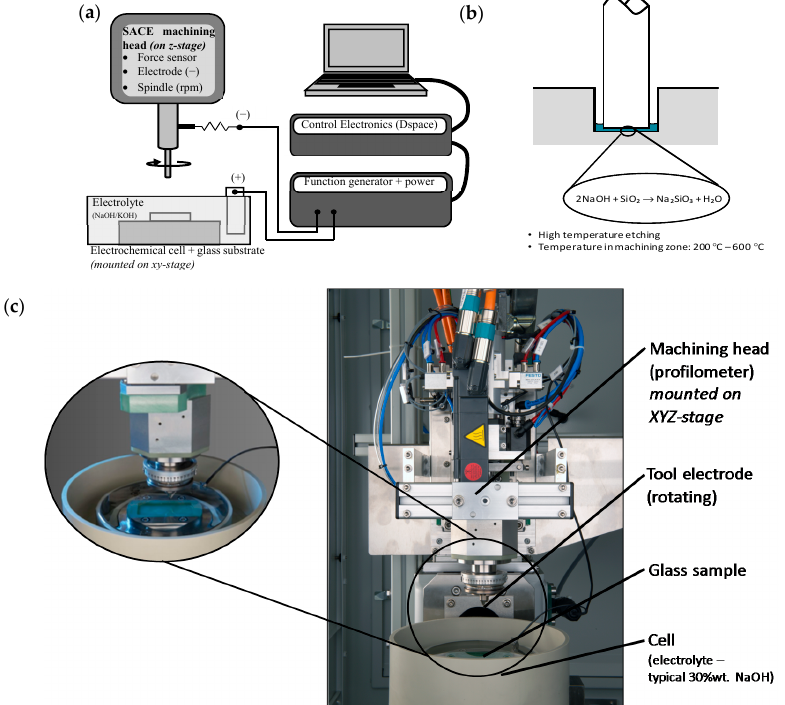
Figure 1. ( a ) Laboratory spark assisted chemical engraving (SACE) versatile glass micromachining setup. ( b ) Chemical mechanism responsible for the localized degradation of the SiO 2 network at the SACE tool tip (blue). ( c ) Image of the industrial Microfor SACE machine (Posalux SA) used in this work with inset showing a close up of the machining zone.